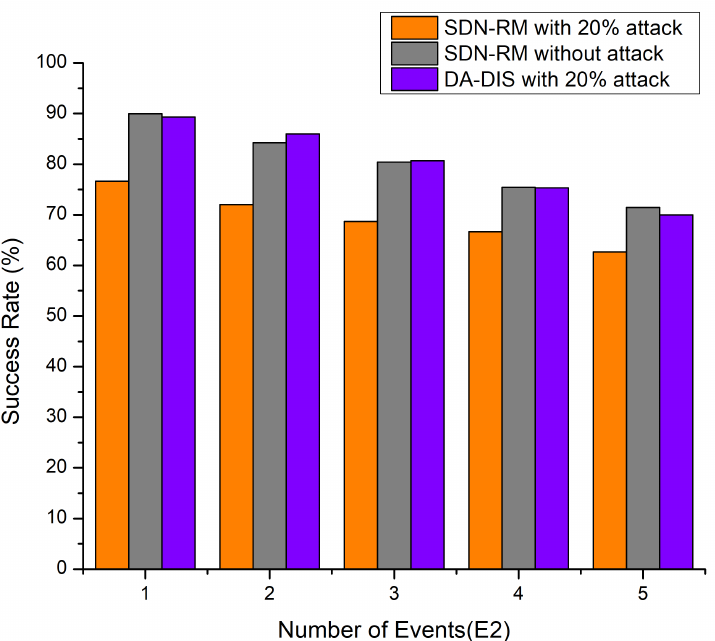
Figure 7. Success Rate considering a different number of events (E2) and 20% malicious switches.